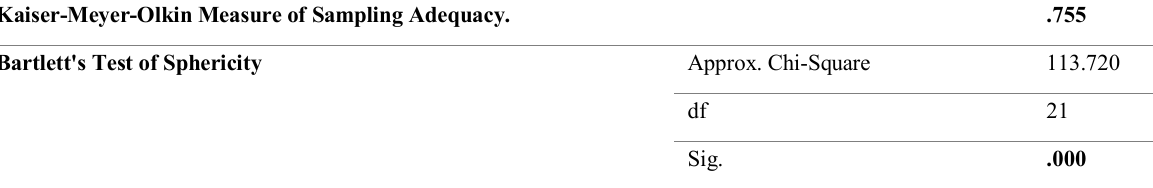
Table 1: Shareholder loyalty factor analysis Kaiser-Meyer-Olkin Measure of Sampling